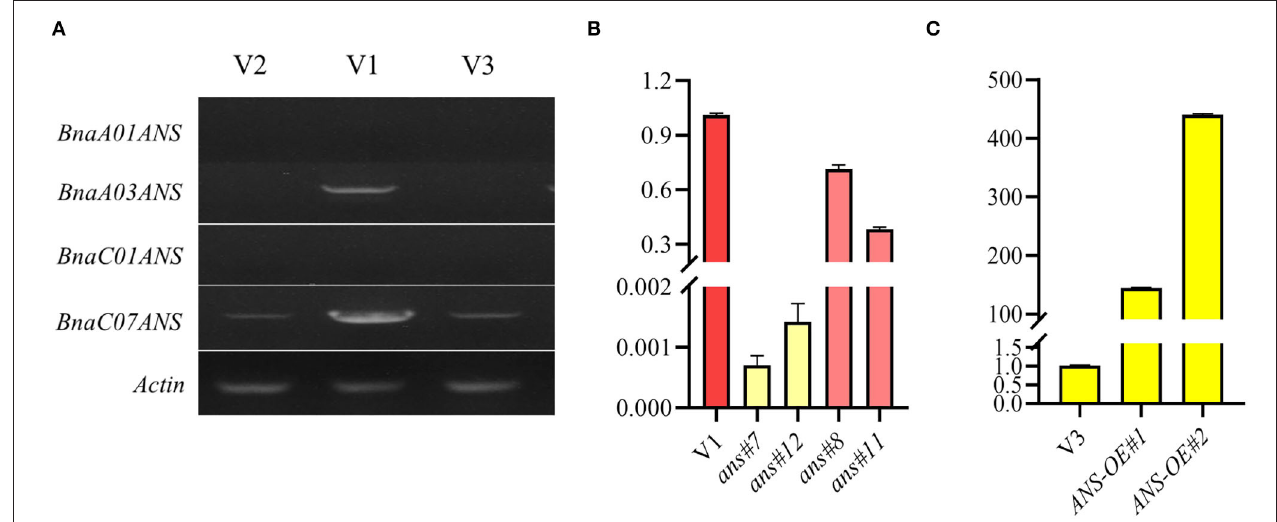
FIGURE 6 | Identification of the expression level of 4 ANS copies, and the BnaA03.ANS expression validation in transgenic lines. (A) Identification of the expression level of 4 ANS copies by semi-RT-PCR; (B) qRT-PCR validation of BnaA03.ANS expression level in RNAi lines compared with the wild type (V1). (C) qRT-PCR validation of BnaA03.ANS expression level in overexpression lines compared with the wild type